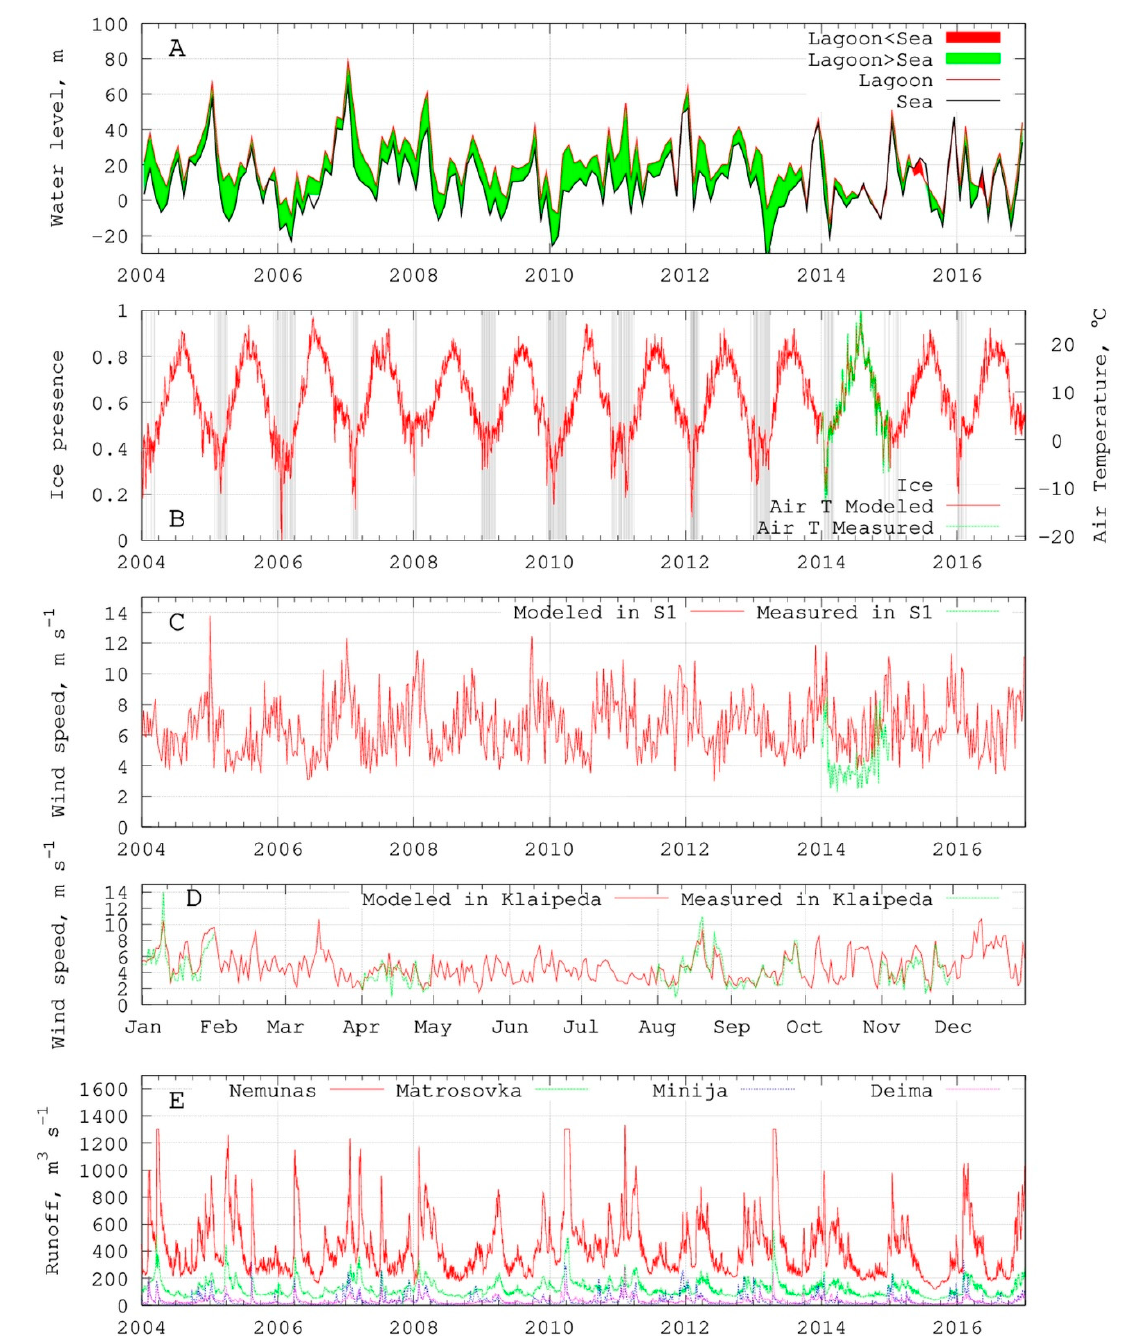
Figure 3. Time series of ( A ) differences between measured water levels in the Klaipeda Strait and Nida; ( B ) measured / modeled (ECMWF) air temperature in Nida and ice cover (grey band) presence in the lagoon from satellite data; ( C ) measured / modeled (ECMWF) weekly averaged wind speed for S1; ( D ) daily measured / modeled only for the year 2014 (ECMWF) wind speed in Klaipeda; ( E ) fresh water discharge into the lagoon.